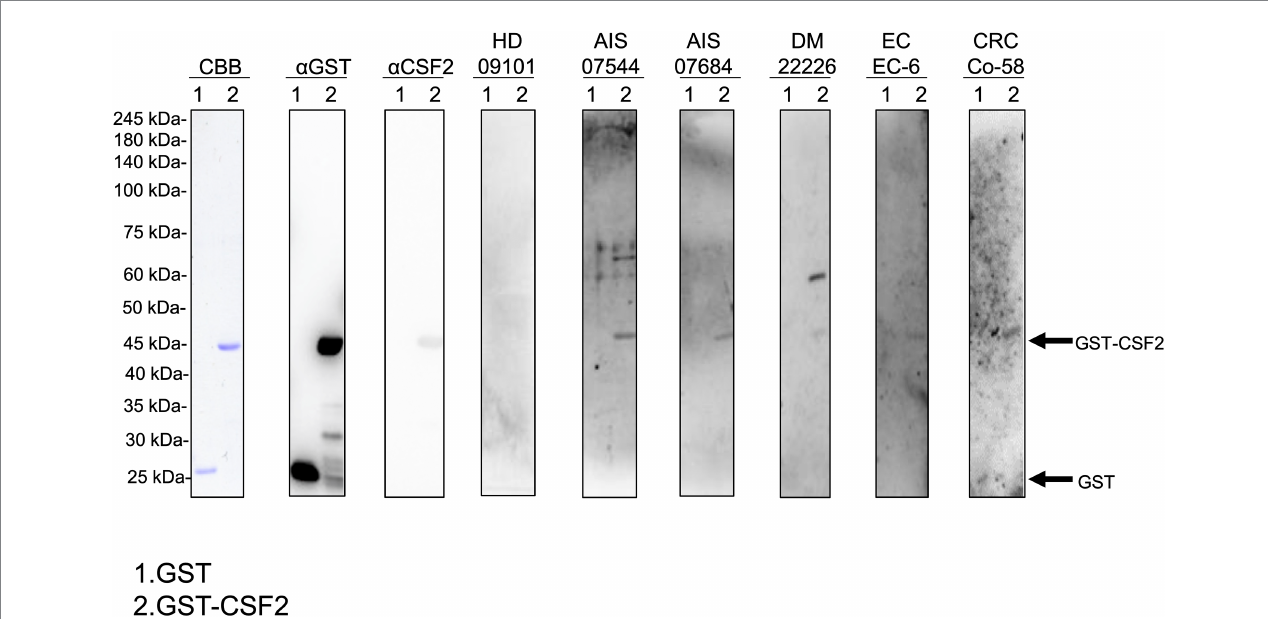
FIGURE 1 Detection of serum antibodies against CSF2. Presence of antibodies against CSF2 in the serum samples of patients with acute ischemic stroke (AIS), diabetes mellitus (DM), esophageal cancer (EC), and colorectal cancer (CRC). Purified GST-CSF2 (lane 1) and GST (lane 2) proteins were separated on sodium dodecyl sulfate–polyacrylamide gels, followed by staining with Coomassie Brilliant Blue (CBB) or western blotting using anti-GST ( α GST), anti-CSF2 ( α CSF2), and serum samples from patients with AIS (07544, 07684), DM (22226), EC (EC-6), and CRC (Co-58) and from a healthy donor (HD)(09101). The full, non-adjusted image of Figure 1 is shown in the Supplementary Figure S1. Molecular weights are presented in the left lane. Arrows indicate the positions of GST-CSF2 (44.6 kDa) and GST (26 kDa). CSF2, colony-stimulating factor